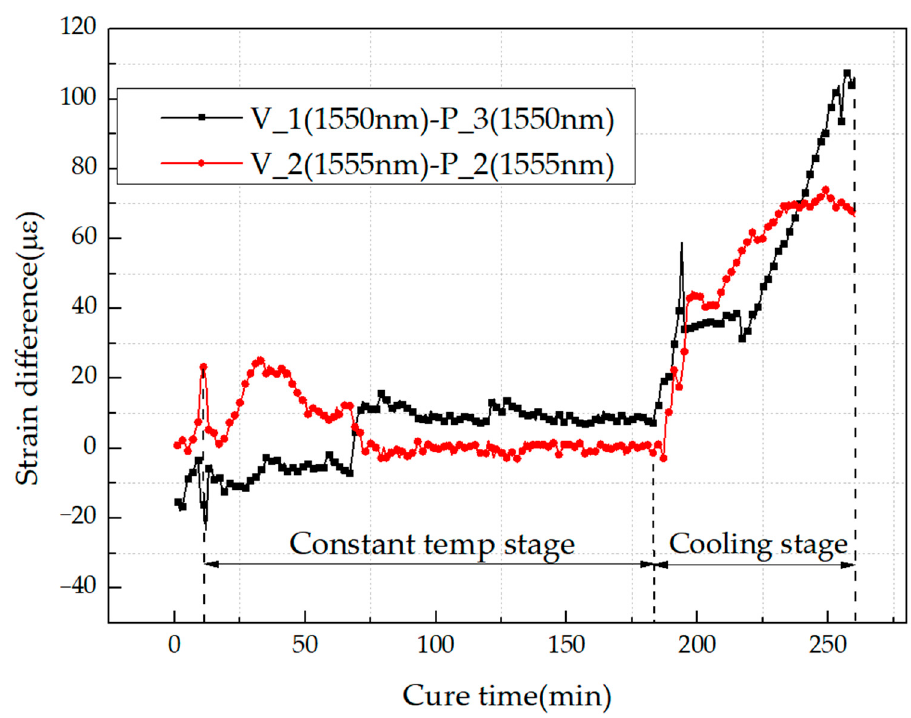
Figure 11. Differences of strain measured by FBG sensors in two orientations during the constant temperature stage and cooling stage.